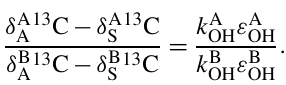
a Values in parenthesis are the standard error of the mean. b Rate constants for 298K (Atkinson and Arey, 2003; Finlayson-Pitts and Pitts, 2000). c Carbon kinetic isotope effects for reaction with OH radicals (Anderson et al., 2004a, b; Rudolph et al., 2002). d Isotopic composition of traffic-related VOC emissions in Toronto (Rudolph et al., 2002). e Average ε calculated from 8.13 (0.8) (Anderson et al., 2004b) and 7.53 (0.5) (Rudolph et al., 2002). f Average of k OH p -xylene = 1 . 43 × 10 − 11 cm 3 molec − 1 s − 1 and k OH m -xylene = 2 . 36 × 10 − 11 cm 3 molec − 1 s − 1 . g ε OH (‰) is for p -xylene; no value is available for